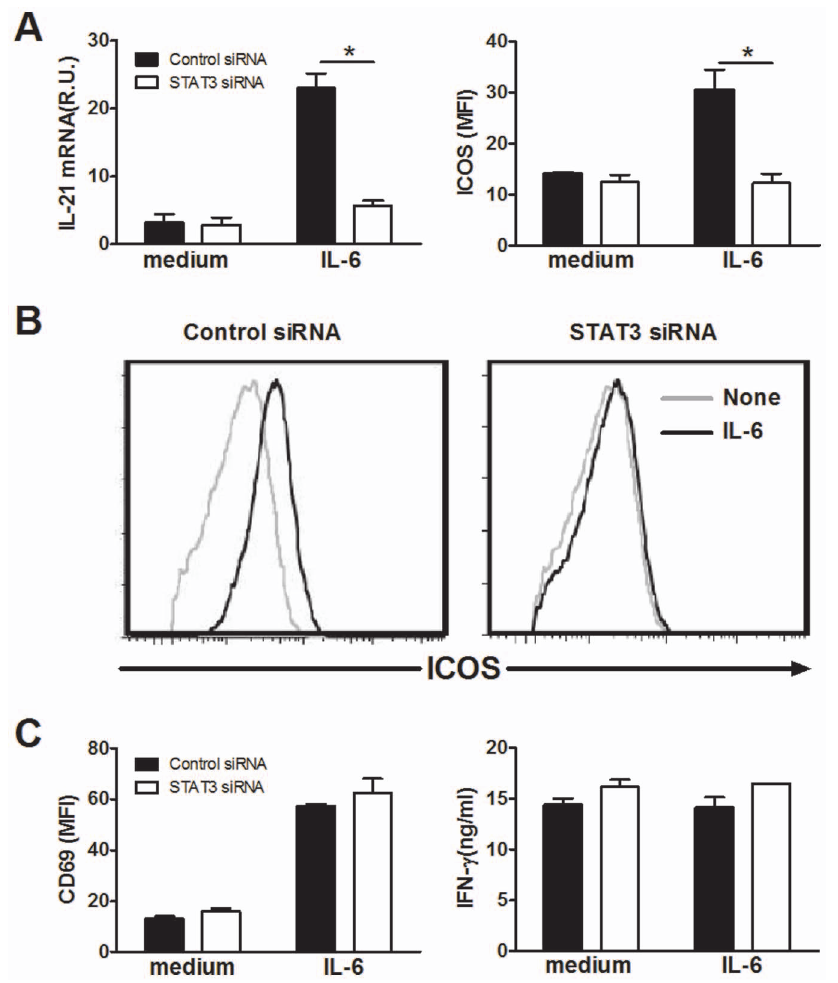
Figure 4. Induction of IL-21 and ICOS expression by IL-6 is STAT3-dependent. Naive cord blood CD4 T cells were transfected with STAT3 specific or control siRNAs in the presence of IL-2. After 48 h, cells were stimulated for 72 hours with plate bound anti-CD3 (5 m g/ml) and soluble anti- CD28 (1 m g/ml) mAbs in the presence of rIL-6 or medium alone before measuring IL-21 production by qRT-PCR (A), membrane expression of ICOS by flow cytometry (A and B), membrane expression of CD69 by flow cytometry and IFN- c production by ELISA (D). Data are individual results or mean 6 SEM of 3 independent experiments on different donors. R.U.: relative units. *p , 0.05 as determined by Student’s t-test.